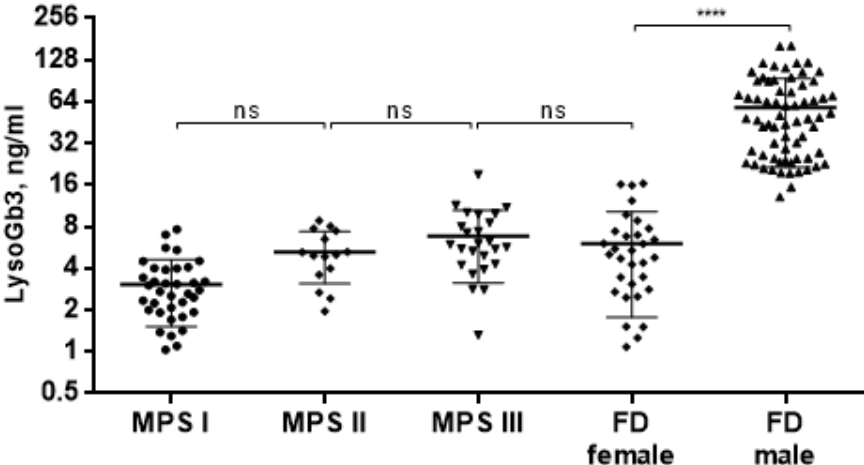
Figure 2. LysoGb3 concentration in patients with different types of MPSs and Fabry disease (FD) patients. **** p < 0.0001.